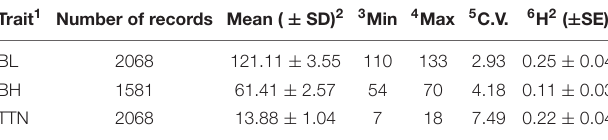
TABLE 1 | Summary statistics of three traits in Large White pig